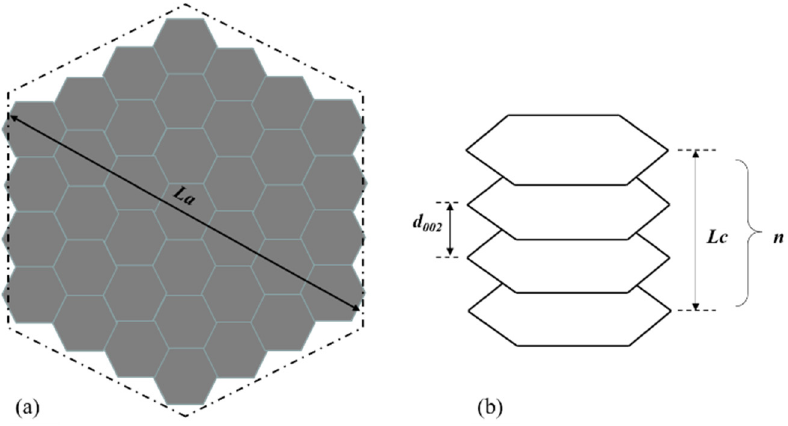
Figure 13. The geometry of an ideal microcrystallite: ( a ) top view; ( b ) side view.